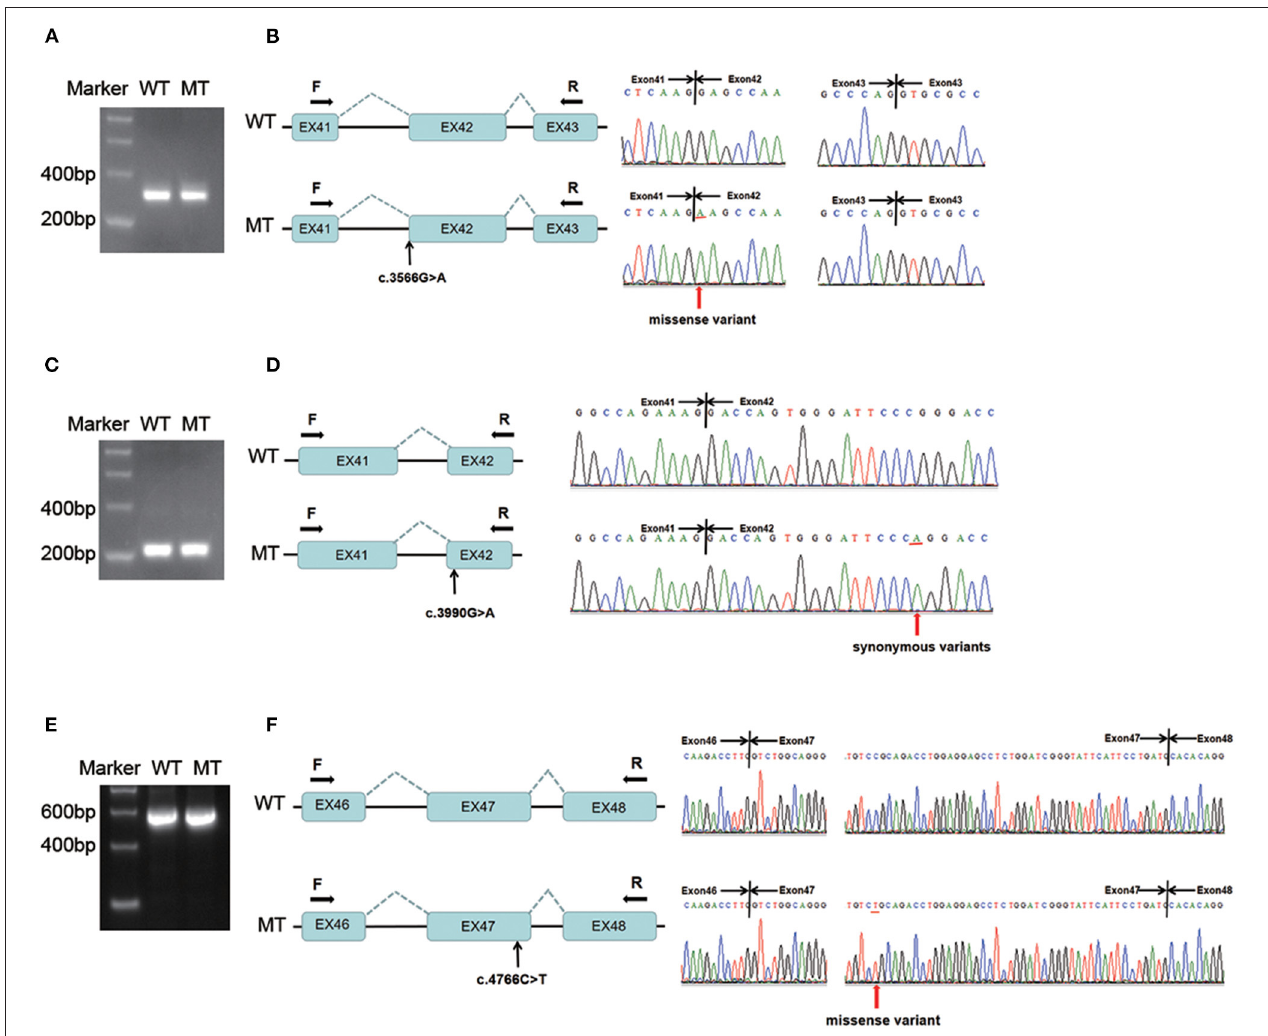
FIGURE 3 | Minigene assay analysis of variants c.3566G > A in COL4A3 and c.3990G > A, c.4766C > T in COL4A4 . (A) The amplification products of the wild-type and variant minigene constructs (c.3566G > A) were separated by 2% agarose gel electrophoresis. The lengths of the two bands were the same. (B) Direct sequencing showed that the two transcripts were identical except for the mutant nucleotide (c.3566G > A). (C) The amplification products of the wild-type and variant minigene constructs (c.3990G > A) were separated by 2% agarose gel electrophoresis. The lengths of the two bands were the same. (D) Direct sequencing showed that the two transcripts were identical except for the mutant nucleotide (c.3990G > A). (E) The amplification products of the wild-type and variant minigene constructs (c.4766C > T) were separated by 2% agarose gel electrophoresis. The lengths of the two bands were the same. (F) Direct sequencing showed that the two transcripts were identical except for the mutant nucleotide position (c.4766C > T). WT, wild-type; MT, mutant-type; F, forward primer; R, reverse